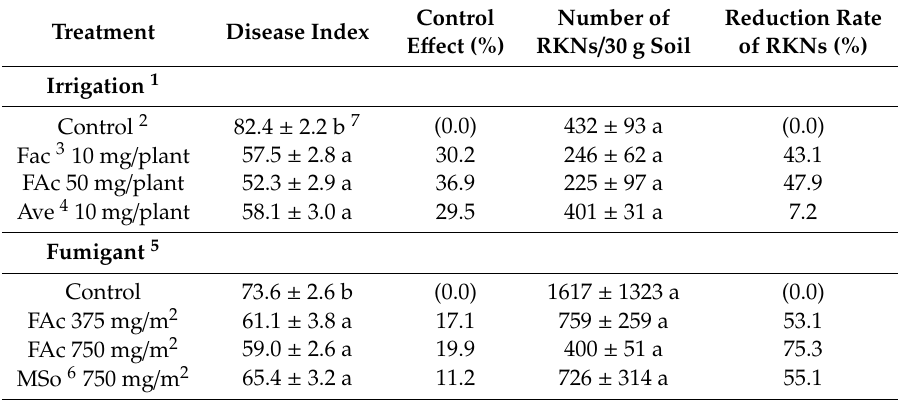
Table 3. Suppression of RKNs by FAc on tomato plants in the field experiments.